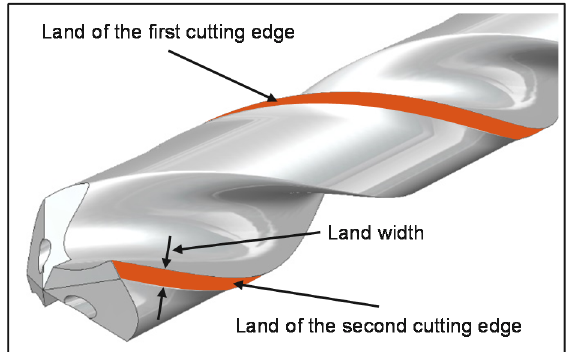
Figure 1. Highlighted lands at the circumference of a twisted drilling tool .